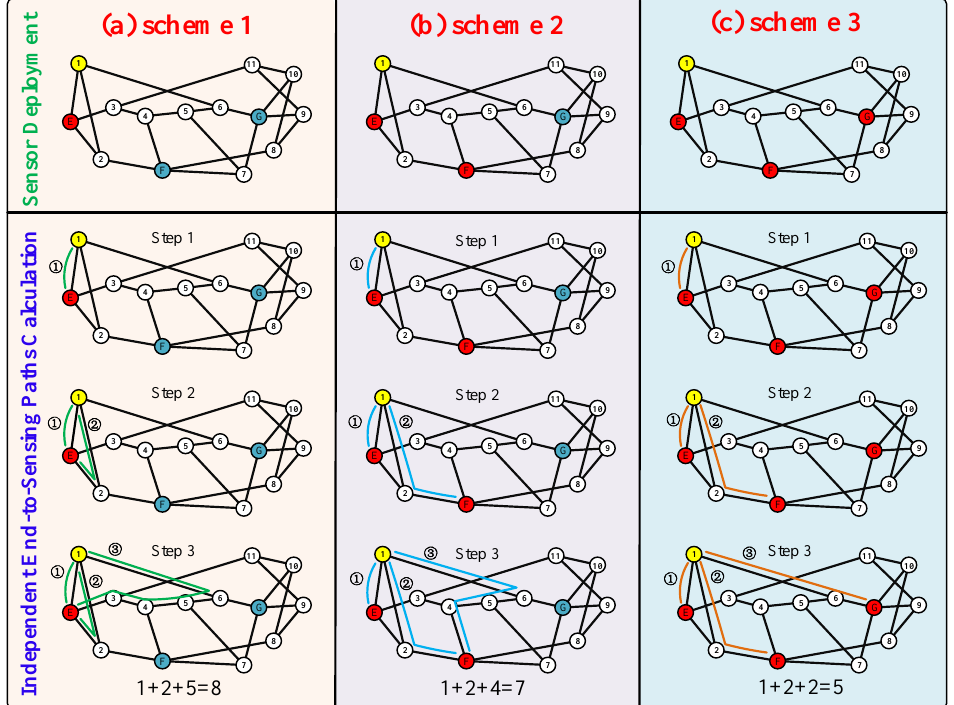
Figure 8. Independent end-to-sensing light path calculations: ( a ) independent end-to-sensing light paths with one available sensor; ( b ) independent end-to-sensing light paths with two available sensors; ( c ) independent end-to-sensing light paths with three available sensors.